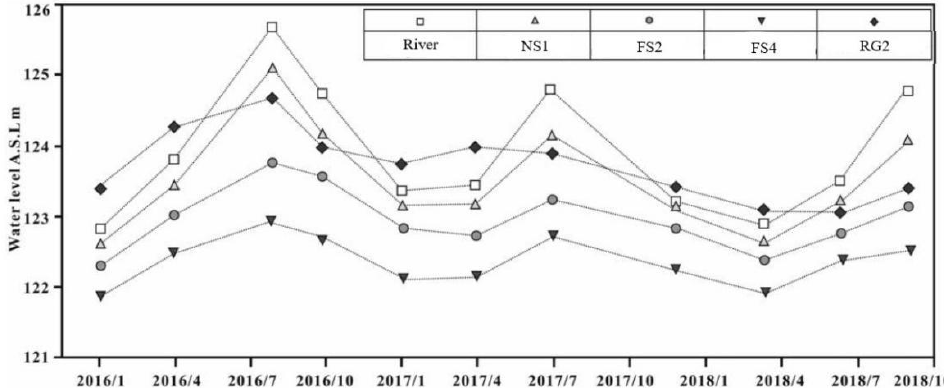
Figure 3. Water level dynamics of river and groundwater. [16].